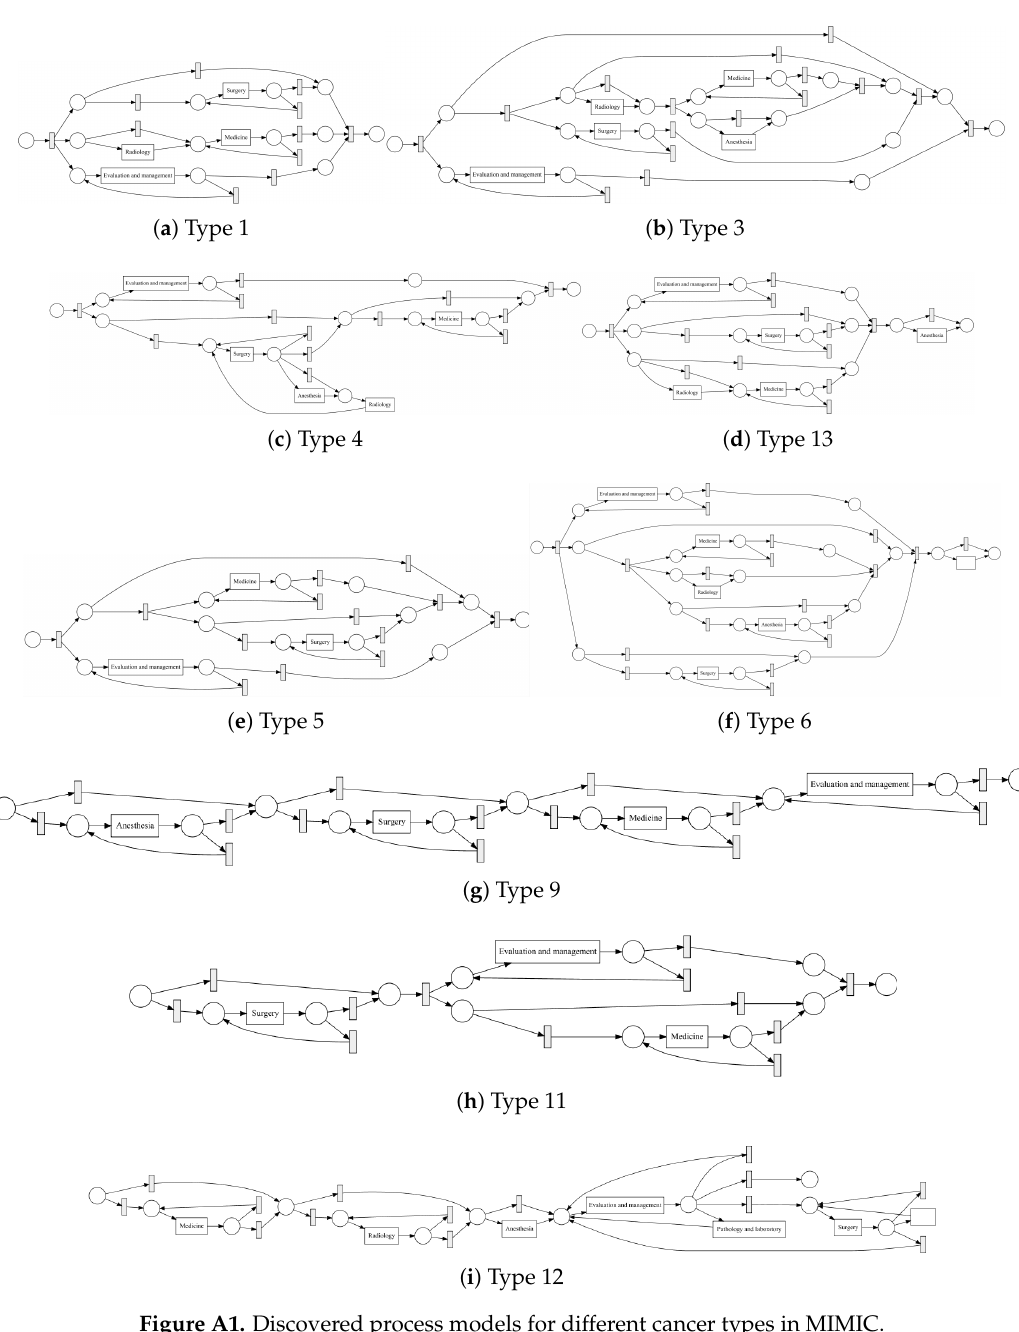
Figure A1. Discovered process models for different cancer types in